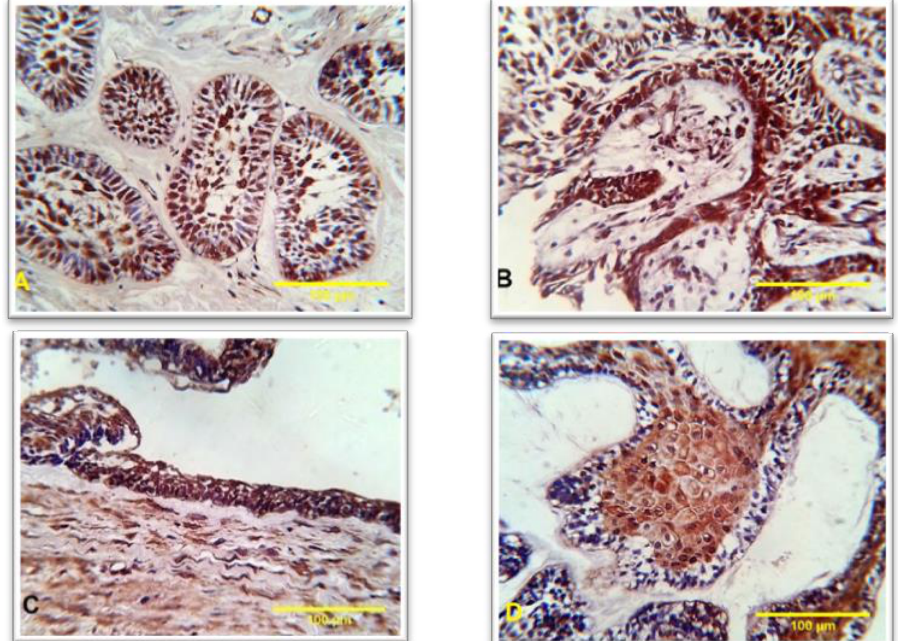
Figure 1: High power photomicrograph depicting immonohistochemical expression of endocan in follicular (A), plexiform (B), cystic (C) and acanthomatous (D) ameloblastomas (X40; scale bar = 100 um